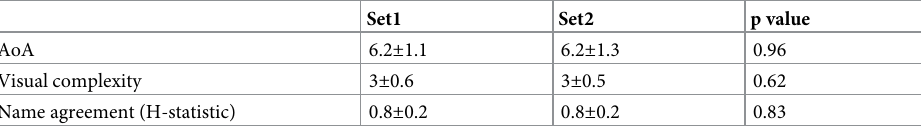
Table 1. Mean ( ± SD), age of acquisition (AoA), visual complexity, name agreement (H-statistic), in isolation for each set of pictures (i.e., each set was the control condition for half the